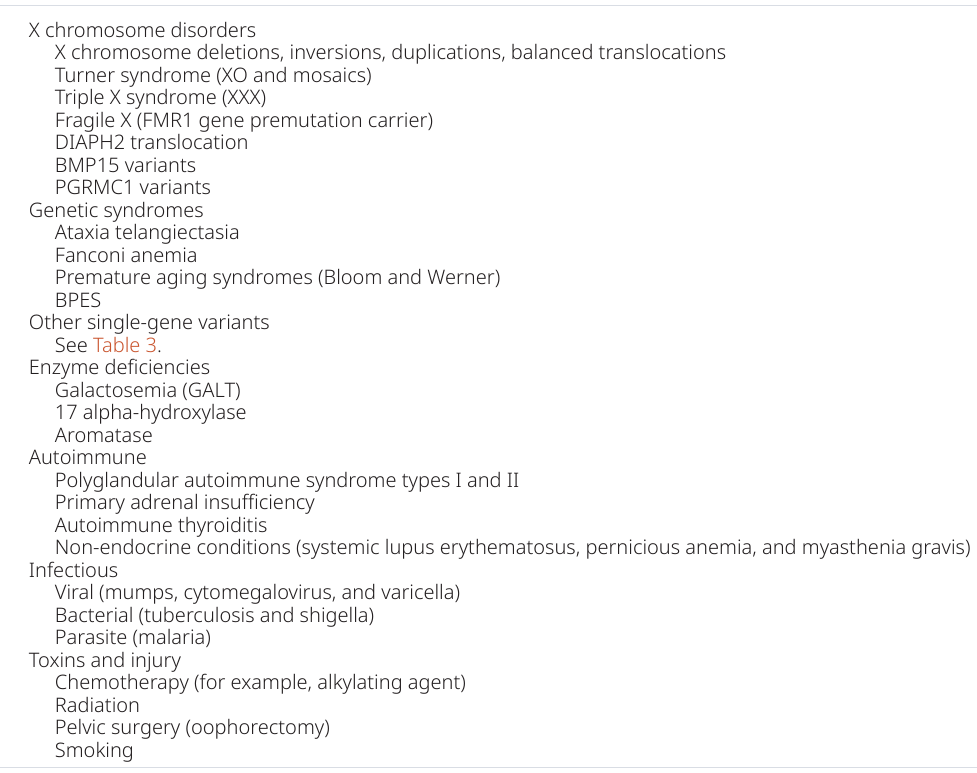
Table 1. Known causes of primary ovarian